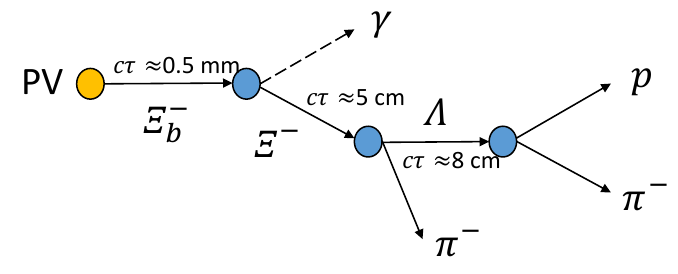
Figure 2 . Topology of the Ξ − particle